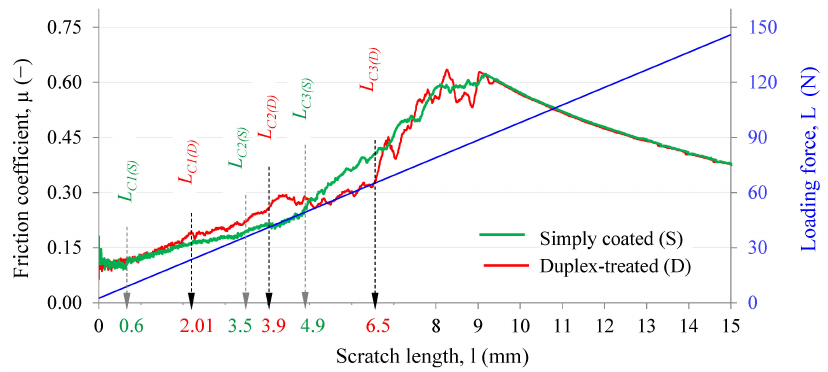
Figure 5. Friction coefficient/loading force vs. scratch length diagrams for simply coated (S) and duplex-treated (D) samples.